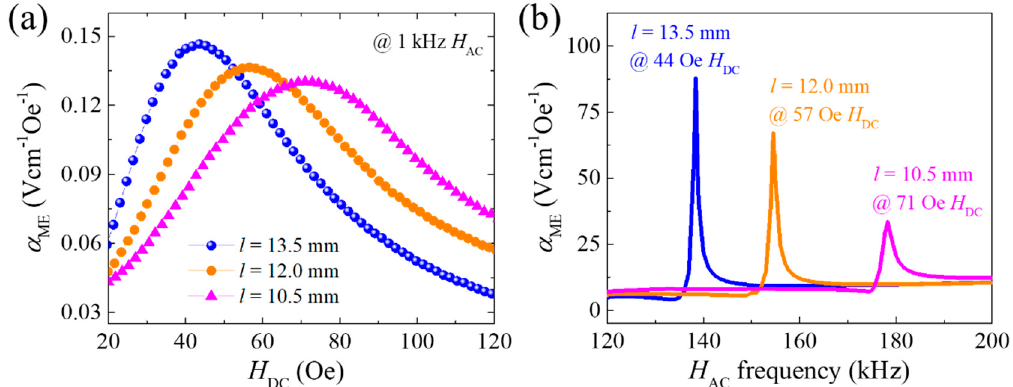
Figure 5. ( a ) Magnetoelectric voltage coefficient of PZT-PMS sensors with different lengths measured at 1 kHz as a function of H DC . ( b ) Magnetoelectric voltage coefficient spectra of the PZT-PMS sensors as a function of H AC frequency. (FE cross-sectional dimensions: 3.0 mm ( w ) × 1.0 mm ( t )).